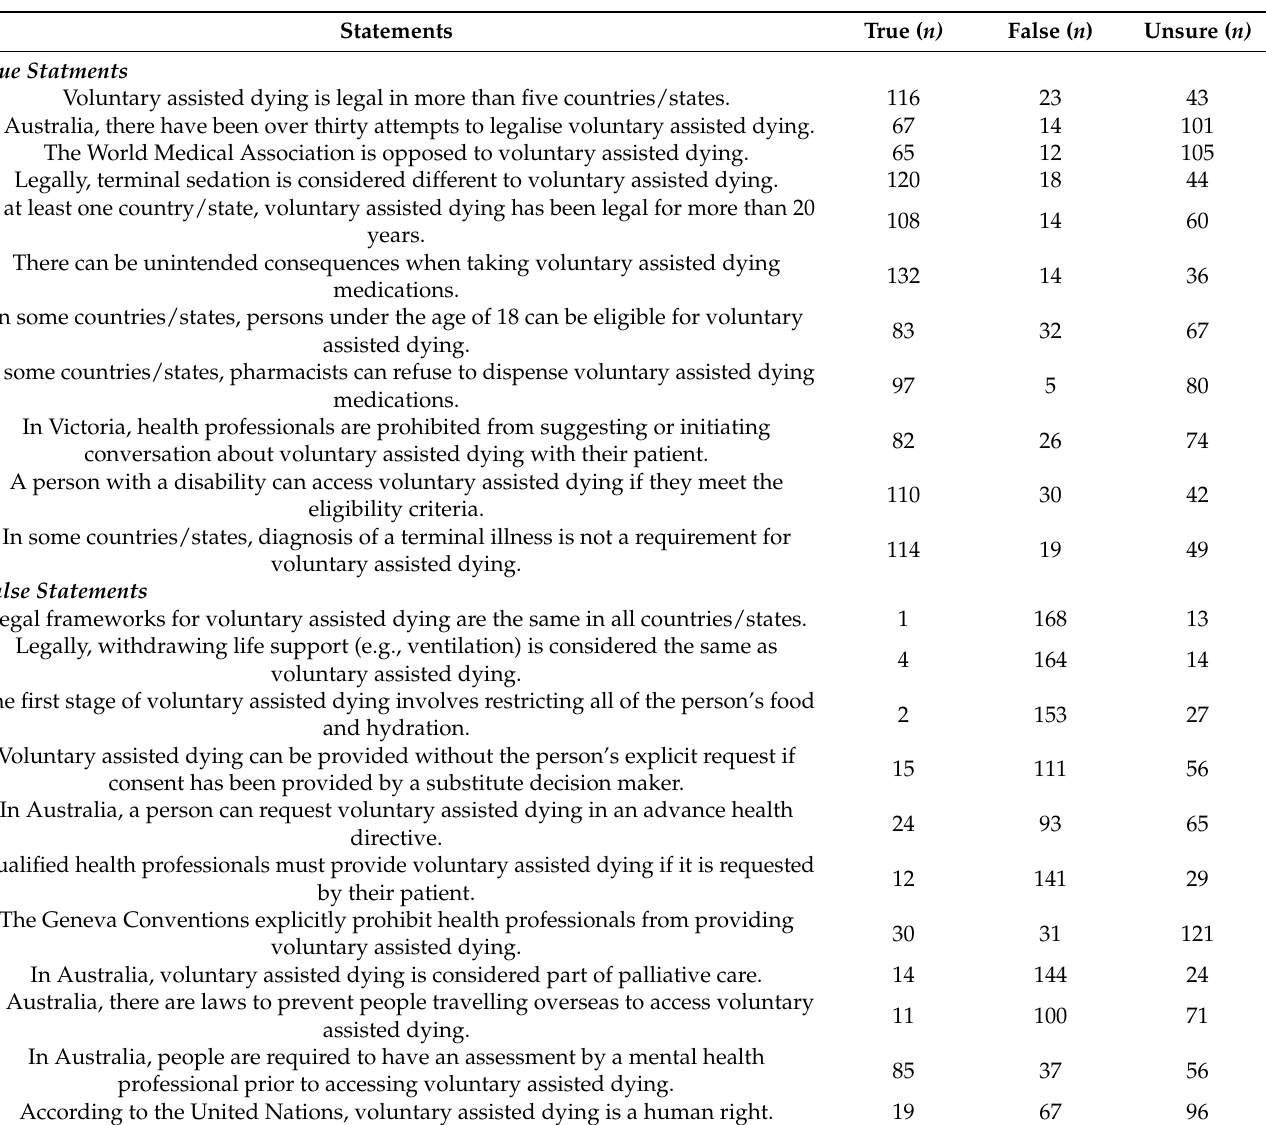
Table 6. Counts of Responses to the Knowledge